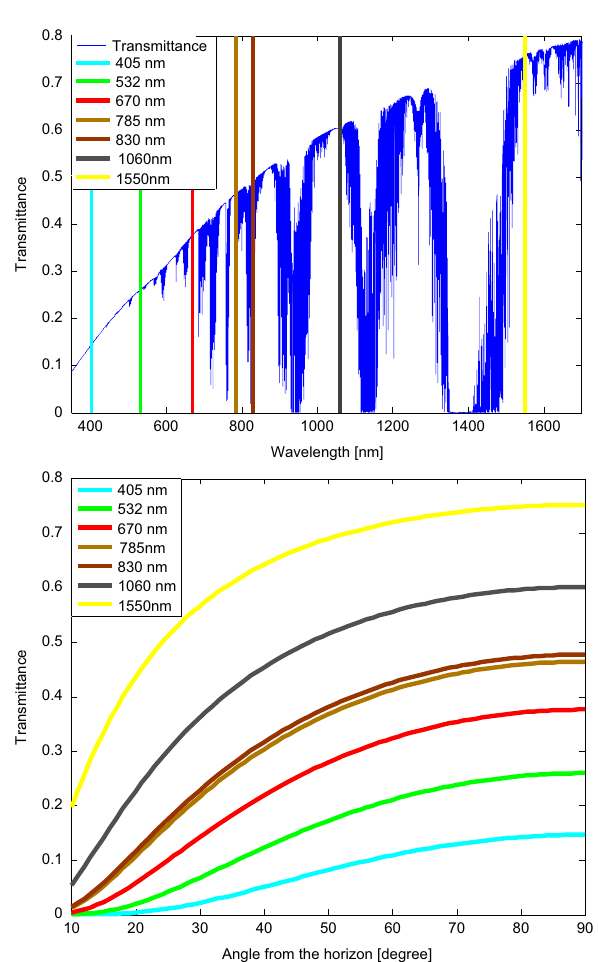
Fig. 4 Simulated transmittance of the atmosphere (adapted from ref. 48). Top – at zenith in a typical rural location with overlaid coloured lines showing the wavelengths of commercially available laser systems. Bottom – as a function of the pointing angle above the horizon for the various